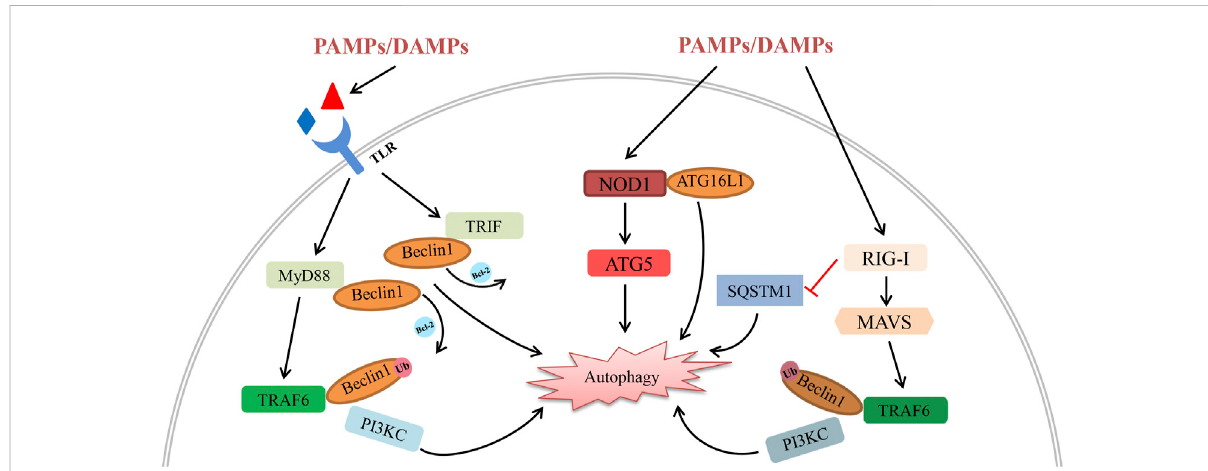
FIGURE 1 SchematicdiagramoftheinterplaybetweenautophagyandPRRs(includingtheirdownstreamsignallingmolecules)inorgantransplantation.All kinds of PAMPs/DAMPs can be recognized by PRRs, activating their downstream signalling pathway following organ transplantation. (1) PAMPs/ DAMPs directly bind to TLRs and activate the MyD88-TRAF6 and TRIF pathways. Activation of TRAF6 induces the K63-linked polyubiquitination of Beclin-1, promoting autophagy degradation by enhancing PI3KC activity. In addition, the interaction between Beclin-1 and MyD88/TRIF induces the dissociation of Beclin-1 and Bcl-2, leading to autophagy initiation. (2) Activation of NOD1 by reperfusion contributes to autophagic degradation via the interaction with ATG16L1 and ATG5. (3) On one hand, the expression of RIG-I decreases SQSTM1 and boosts autophagic degradation. On the other hand, activation of RIG-I triggers autophagy via the MAVS-TRAF6-Beclin-1 signalling